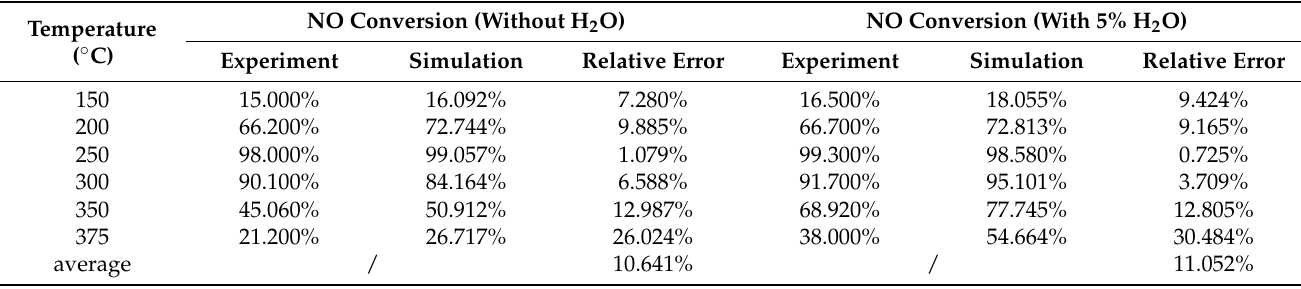
Table 7. The results with relative errors of NO conversion between experiment and simulation under two operating